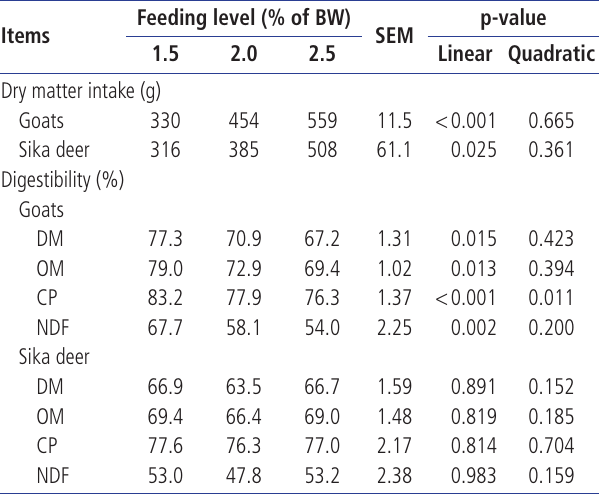
Table 2. Effect of feeding levels on nutrient digestibility in goats (Capra hircus hircus) and Sika deer (Cervus nippon hortulorum)